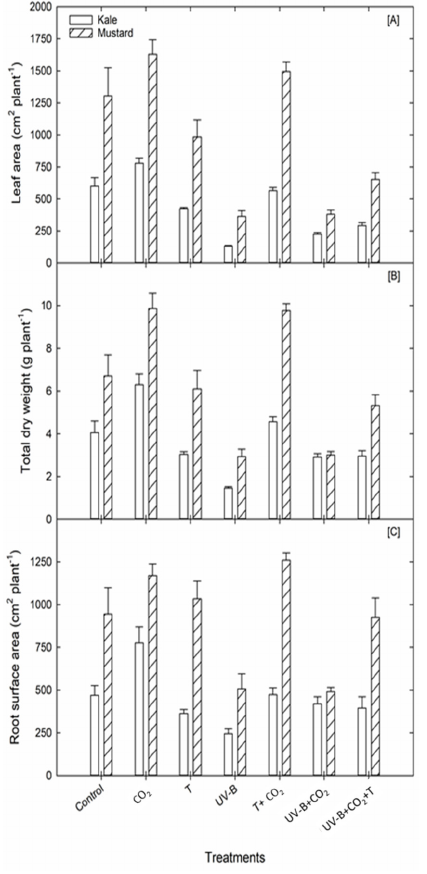
Figure 2. Impact of CO 2 concentration (control, 400 µ mol mol − 1 and +CO 2 , 720 µ mol mol − 1 ), elevated temperatures (25/17 °C and 35/27 °C (day/night)), and UV-B radiation (control, 0 and +UV-B, 10 kJ m − 2 d − 1 ), and their interactions on ( A ) leaf area, ( B ) total dry weight and ( C ) root surface area for kale and mustard. Bars indicate standard errors of the mean.